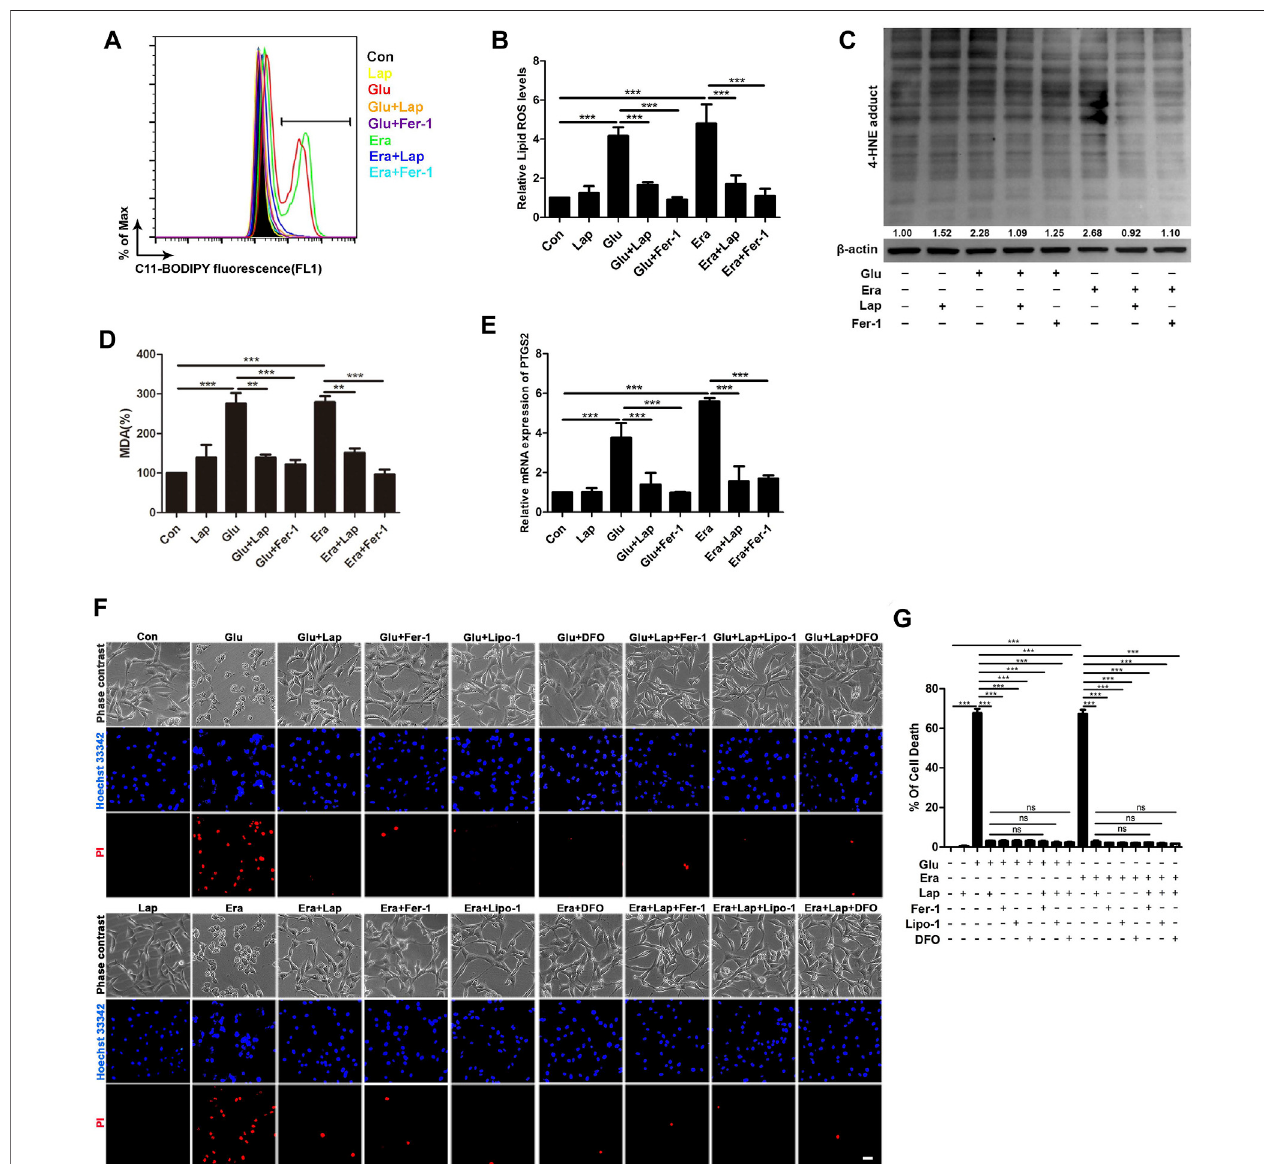
FIGURE5| Lapatinib preventsGlu-or erastin-induced neuronal deathpossibly bysuppressingferroptosis (A – D) Detection oflipidROS,4-HNE and MDAcontent in the glutamate (Glu)- or erastin (Era)-induced HT22 cell death model following lapatinib (Lap) (10 μ M) and ferrostatin-1 (Fer-1) (12.5 μ M) pretreatment for 2 h (E) RT- qPCR analysis of PTGS2 mRNA expression pretreated with or without Lap (10 μ M) and Fer-1 (12.5 μ M) in HT22 cells induced by Glu or Era (F,G) Comparisons of combination of Lap and ferroptosis inhibitors and Lap alone in HT22 cells following Glu or Era challenge when pretreatment with Lap (10 μ M), Fer-1 (12.5 μ M), liproxstatin-1 (Lip-1) (1 μ M) and deferoxamine (DFO) (50 μ M) pretreatment for 2 h. Scale bar: 200 μ m. All results were presented as the mean ± SEM from three independent experiments, ns indicates no statistical signi fi cance. ** p < 0.01 and *** p < 0.001.